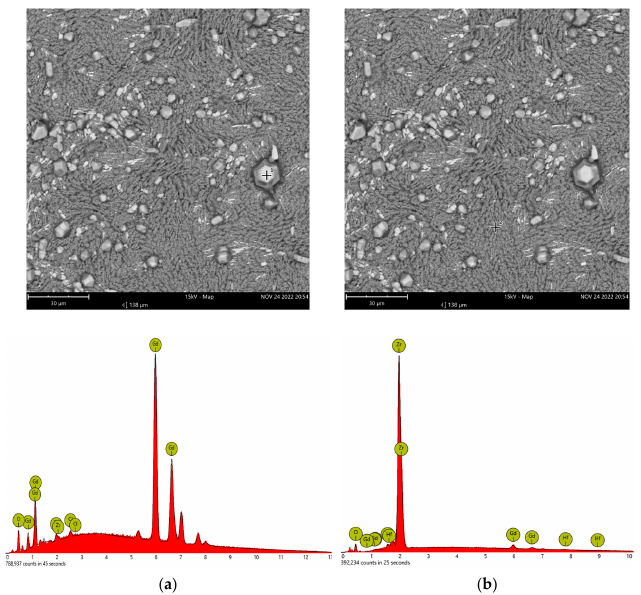
Figure 14. SEM images and EDS data for the sample of 0.90Gd 2 Zr 2 O 7 -0.10MgO after exposure for 48 h in a LiCl-2wt.%Li 2 O melt at T = 650 °C ( a ). SEM images of and EDS spectrum of the 0.90Gd 2 Zr 2 O 7 - 0.10MgO sample after exposure for 48 h in the LiCl-2 wt.%Li 2 O melt at T = 650 °C ( b ).